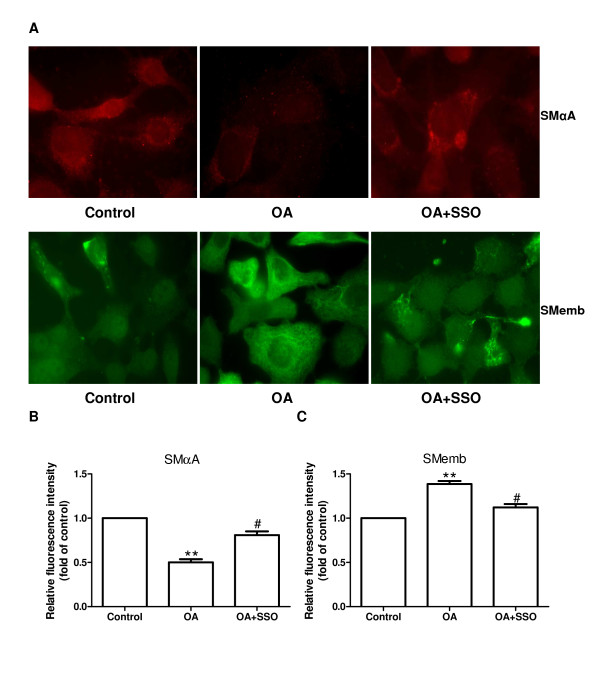
OA modulates vascular SMC phenotype. (A) Immunofluorescence staining of SMαA and SMemb proteins in rat aortic SMCs after incubation for 48 hours with vehicle (control), OA (250 μmol/L), or OA (250 μmol/L) plus SSO (250 μmol/L). Magnification ×400. (B, C) Summarized data showing the average fluorescence intensity in cells from each group. Data are expressed as mean ± SEM. ** p < 0.01 compared with the control group, # p < 0.05 compared with the cells treated with OA alone. OA, oleic acid; SMCs, smooth muscle cells; SSO, sulfosuccinimidyl oleate; SMαA, smooth muscle α-actin; SMemb, embryonic smooth muscle myosin heavy chain.